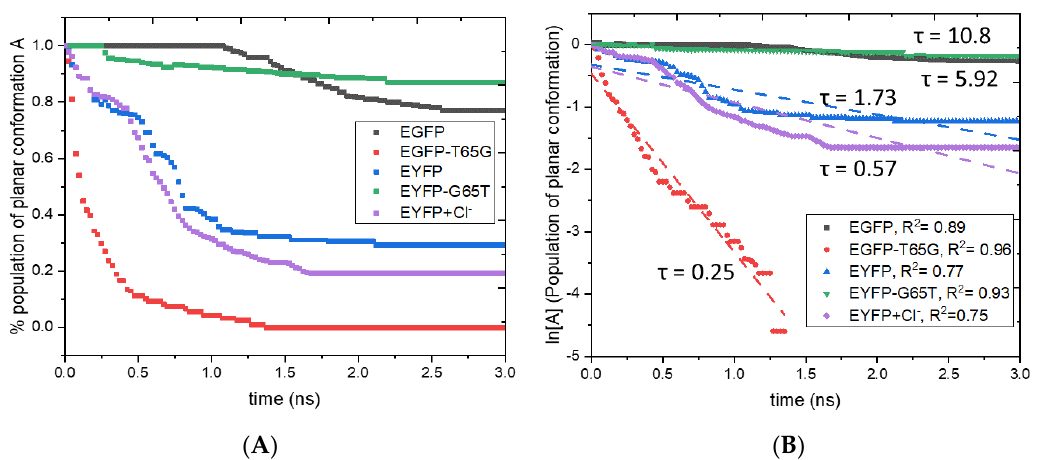
Figure 8. Left: Evolution of planar ( A ) population in excited-state molecular dynamics simulations of EGFP, EGFP-T65G, EYFP, EYFP-G65T, and EYFP + Cl – . ( B ) Right: Linear fit for ln[A].